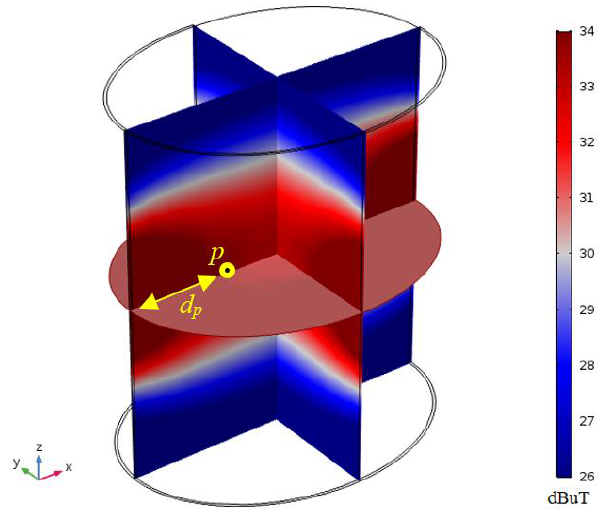
Figure 8. Magnetic-field distribution inside trunk for N 1 = 2, s 1 = 0.08 m and MMF 1 = 14 At.